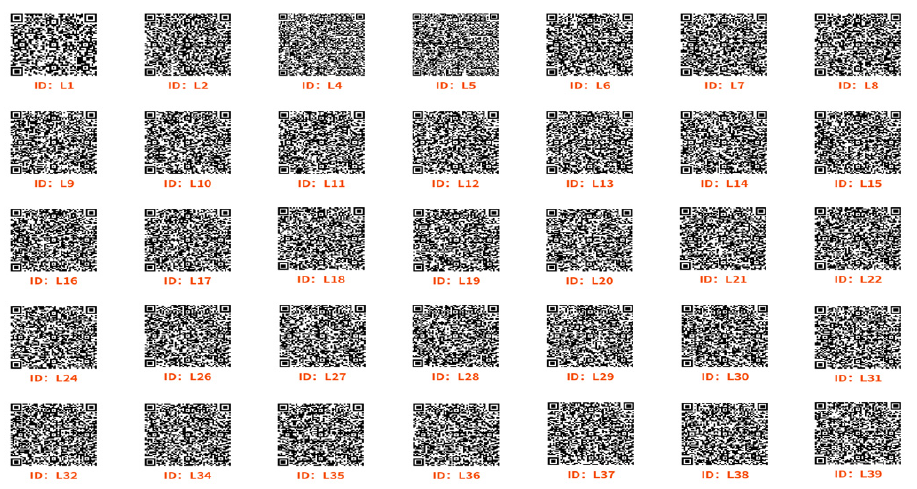
Figure 5. Two-dimensional barcodes of the 35 tea germplasms. Each 2D barcode contains the genotype information.